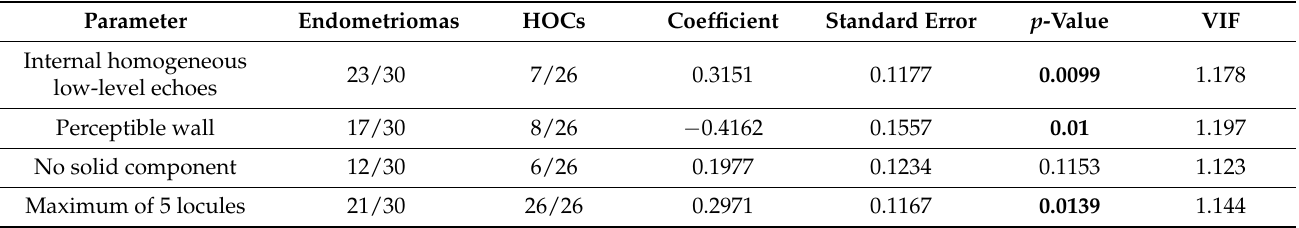
Table 2. The multivariate analysis showing independent features associated with the presence of endometriomas. The cases in which a specific feature could be found in either group are displayed as number/total.